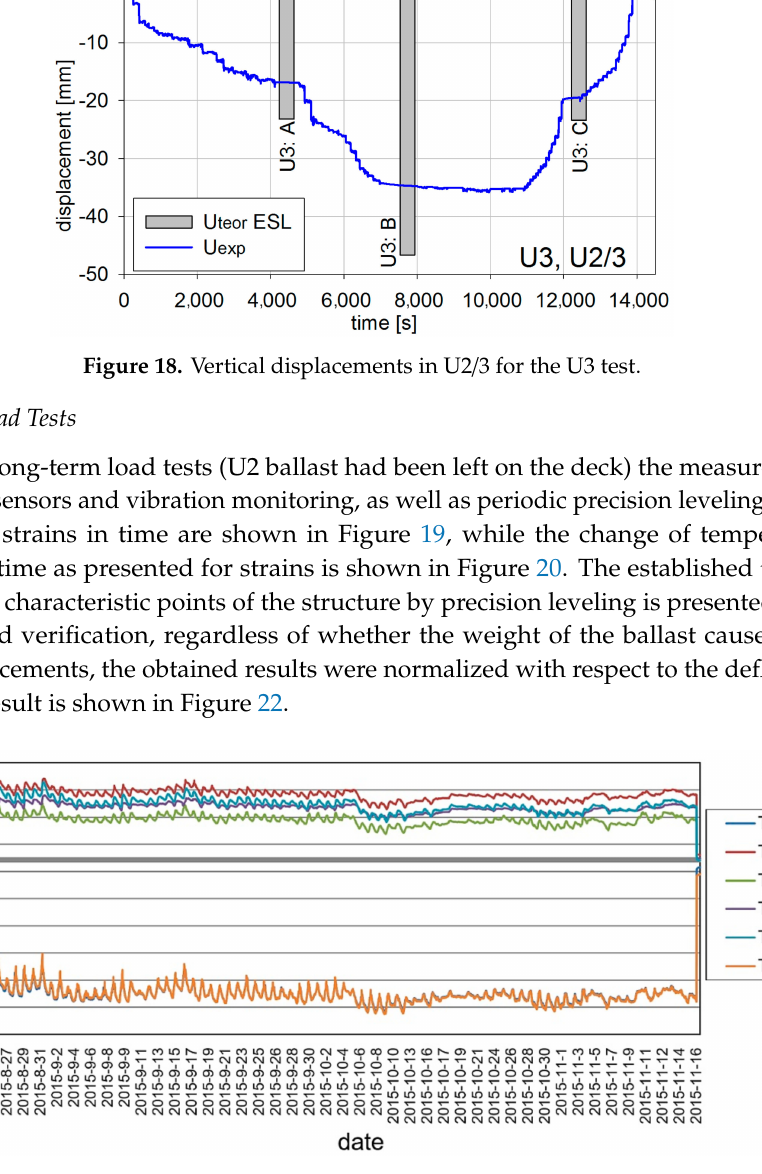
Figure 19. Strain monitoring using VWSG sensors during the long-term load test.